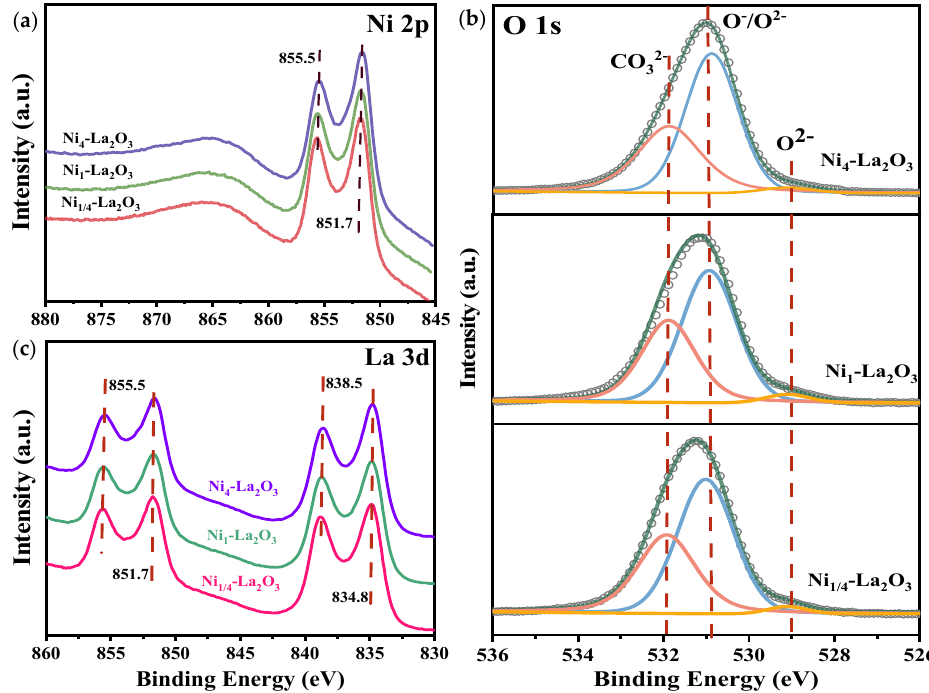
Figure 2. XPS spectra of Ni x -La 2 O 3 catalysts with different nickel capacities: ( a ) Ni 2p; ( b ) O 1s; ( c ) La 3d.